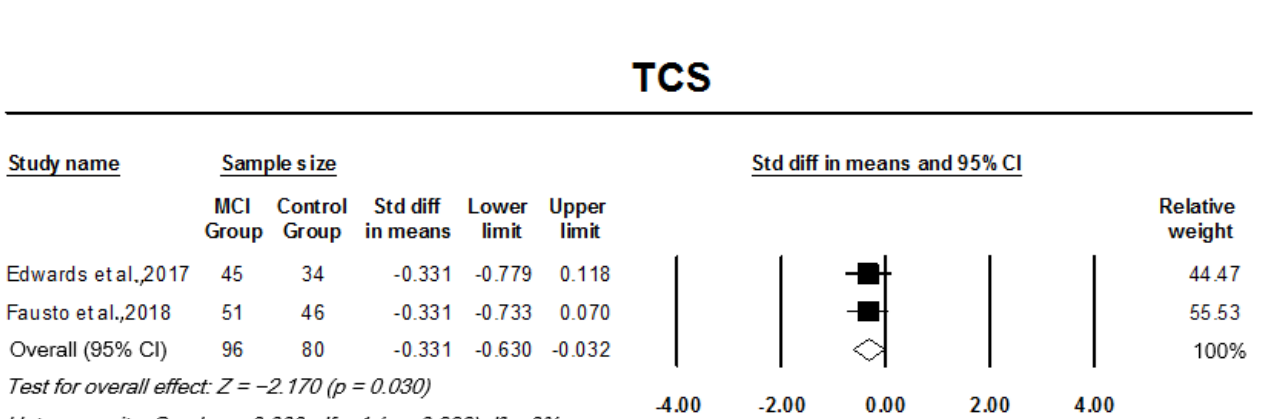
lines represent the 95% confidence interval (CI) for each computed standard mean difference. Weights are from the random-effects analysis.